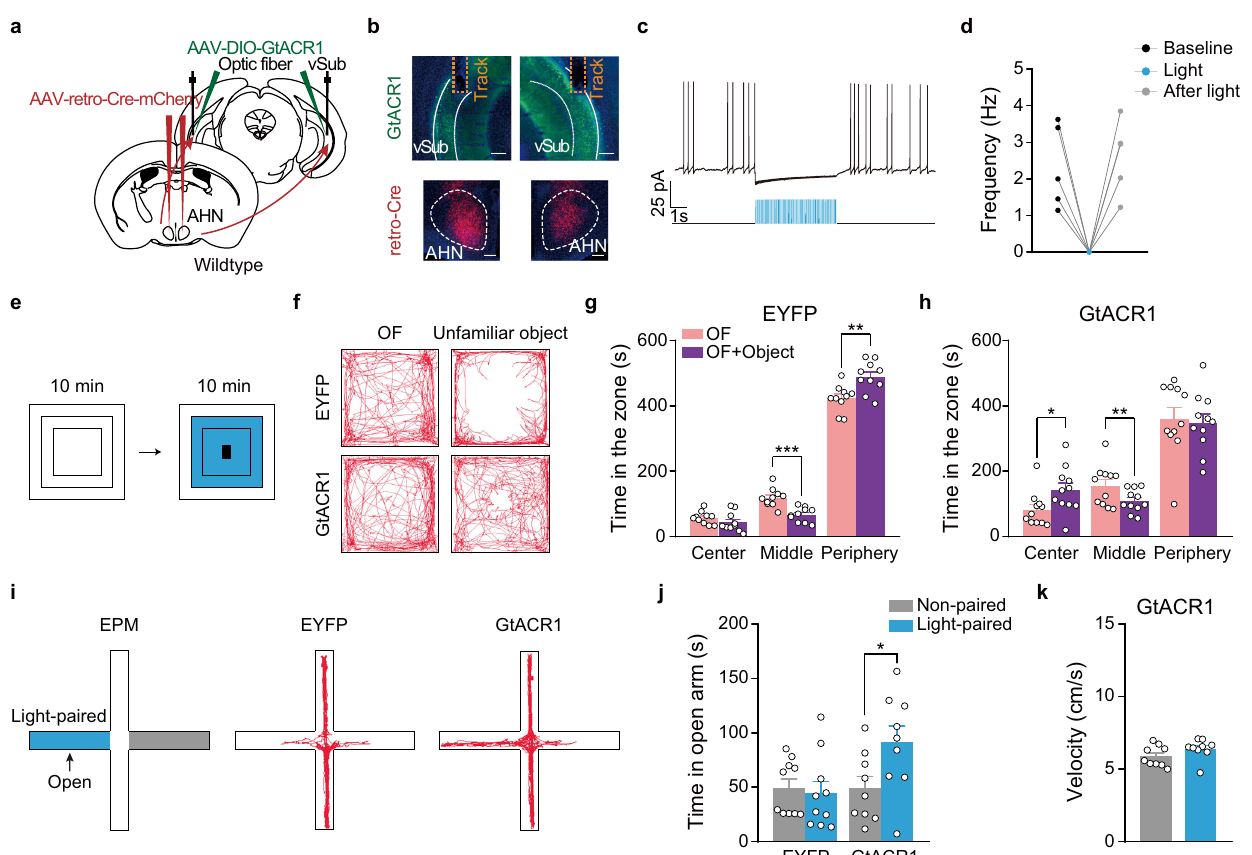
Fig. 7 | Inhibiting AHN-projecting vSub neurons diminishes anxiety-like avoidance behavior. a Schematics of the strategy to retrogradely target and bilaterally inhibit AHN-projecting vSub neurons. b Representative images showing GtACR1 expression in vSub (top), and retro-Creexpression in AHN (bottom). Scale bar,200 μ m. c , d Arepresentativetrace( c )andquanti fi cations( d )showingtrainsof light pulses (473nm, 20ms, 20Hz), represented as blue lines, acutely and rever- sibly inhibit the fi ring of GtACR1-expressing cells. e – h GtACR1-mediated inhibition of AHN-projecting vSub neurons in open fi eld. n =10 EYFP and 11 GtACR1 animals. e Schematicsoflight deliveryrestrictedto the center and middlezone after object introduction. f Example open fi eld trajectories of an EYFP and a GtACR1 male. g , h Time spent in the center, middle and periphery zones before and after object